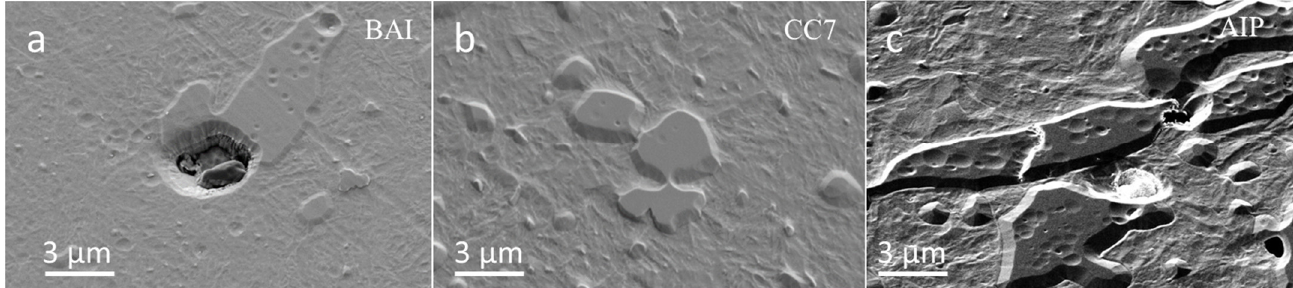
Figure 2. Top-view SEM images of D2 tool steel substrates after ion etching in BAI ( a ), CC7 ( b ) and AIP ( c ) deposition systems. AIP ( c ) deposition